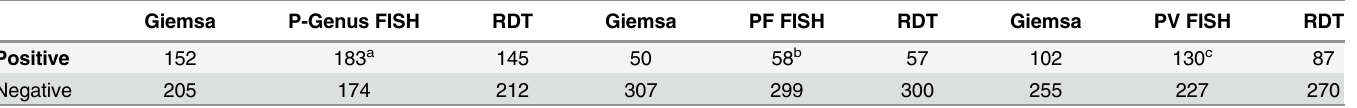
Table 2. Summary of Clinical Study Results. Giemsa negative, PCR and FISH Positive samples a = 17; b = 5; c = 14. (Note: 150 samples from US are excluded)